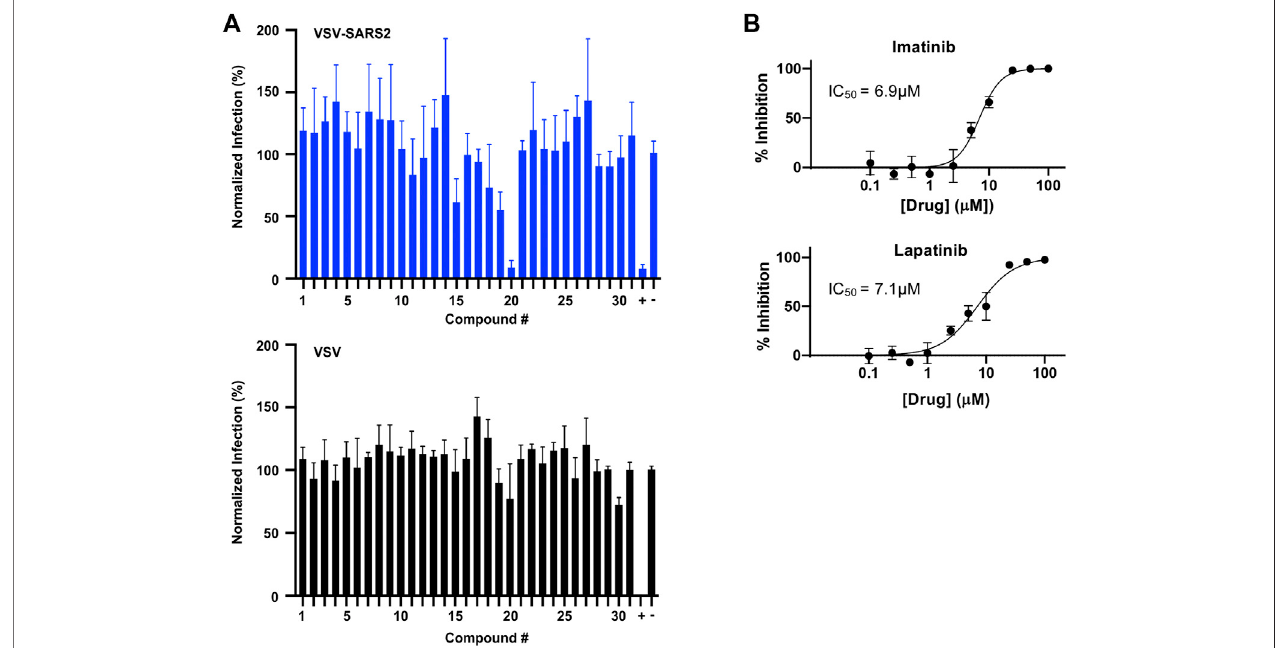
FIGURE 5 | Predicted spike drug inhibitors screened using a VSV-SARS2 infection assay reveals two promising hits. (A) Individual drugs from the library set were used at 10 μ M totreat GFP reporter viruses, VSV-SARS2 and VSV, for30 min prior toinfection ofVero cells at 0.5 MOI or 0.1 MOI respectively. The infection media was replaced with fresh media at 1 h post-infection and fl uorescent reporter values were measured the next day. (B) Half-maximal inhibitory concentration (IC 50 ) curves and valueswere obtained forImatinib(compound 20)and Lapatinib (compound 19) using thesame VSV-SARS infection assayperformedfor library screening. All data were normalized as percent infection or inhibition for drug-treated conditions vs. no-treatment control. The values are means, with error bars displaying standard deviation between the triplicate